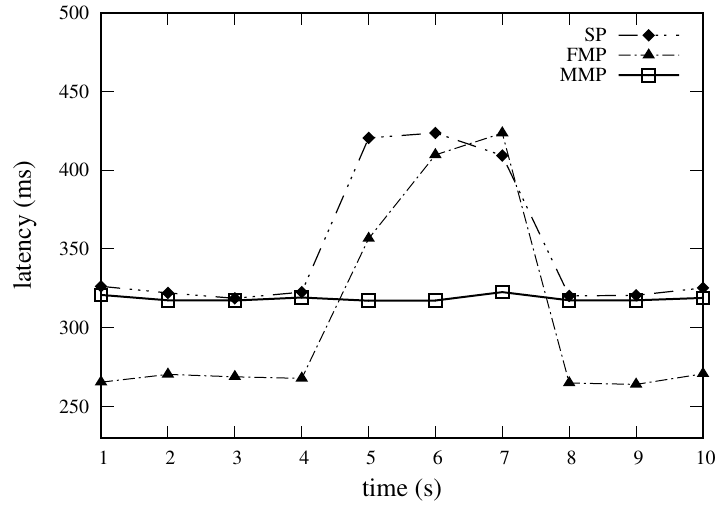
Figure 6. Latency comparison of FMP and MMP when traffic congestion occurs during 4–7 s. Both paths of SP and FMP are affected, whereas the alternative path that MMP found is unaffected.